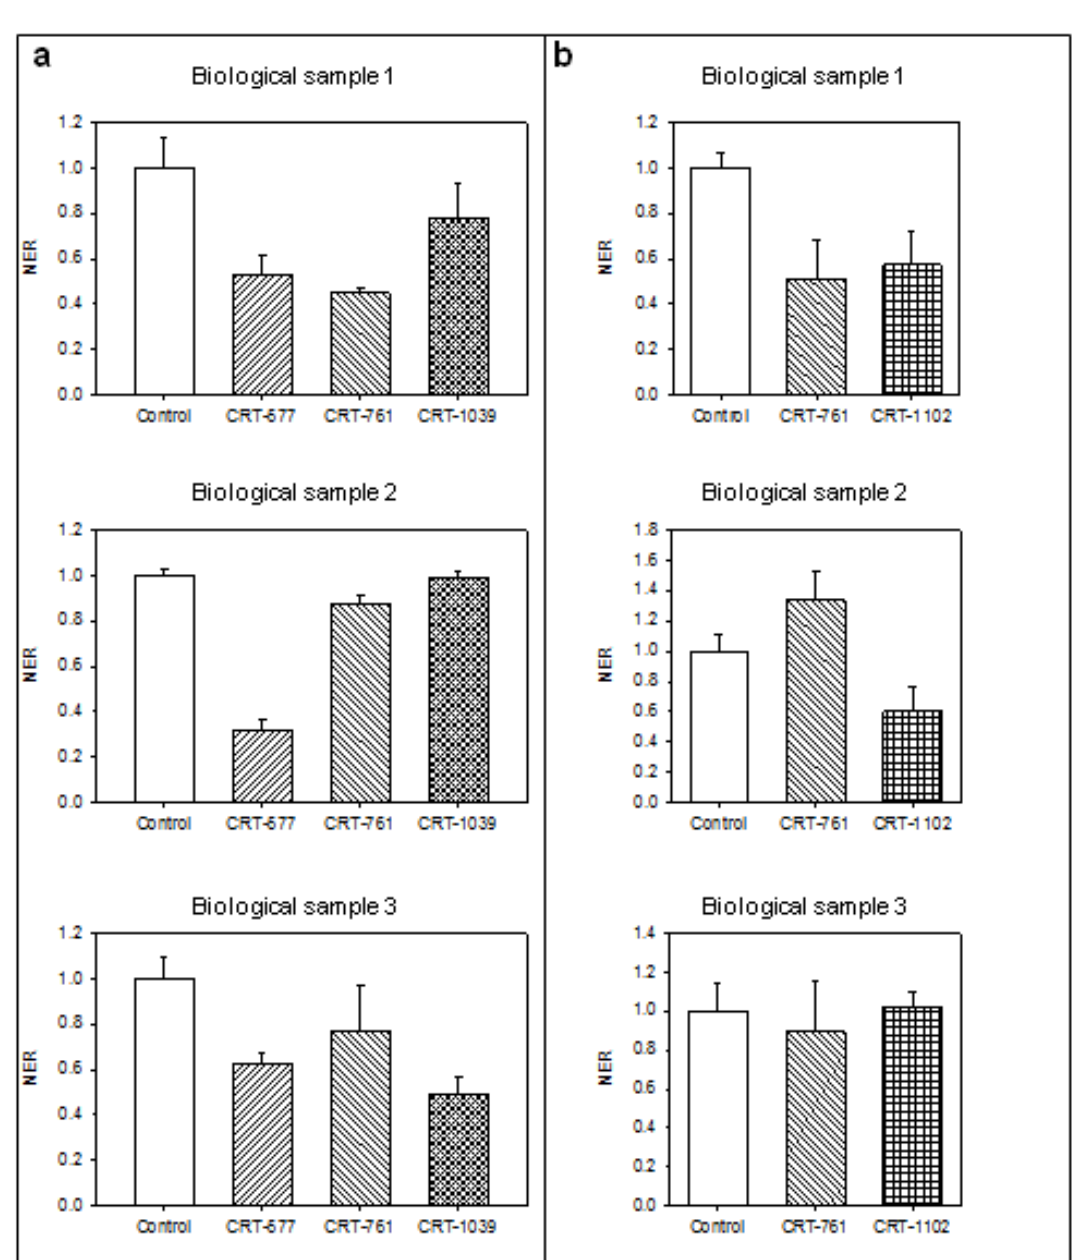
Figure 4. Reproducibility of gene-silencing efficiency after soaking in siRNAs. Mi-CRT silencing in three biologically independent experiments. ( a ) Normalized expression rate (NER) of Mi-CRT after 1 hour soaking in random siRNA (control), siRNA CRT-577, CRT-761 or CRT-1039 followed by 24 hours incubation in water; ( b ) Mi-CRT NER after 24 hours soaking in siRNA CRT-761 or CRT-1102. The relative quantity of Mi-CRT transcripts was quantified by Reverse Transcription (cid:178) quantitative PCR using GAPDH (Minc10963 and Minc12412) and actin (Minc06769 and Minc06773) genes as reference genes. For each soaking condition, histograms show the mean and its standard error calculate on technical duplicates undertaken on three first strand cDNA templates obtained from three RNA